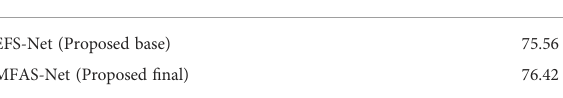
TABLE 4 Comparison of EFS-Net and MFAS-Net ’ s numerical results on the SUIM dataset.